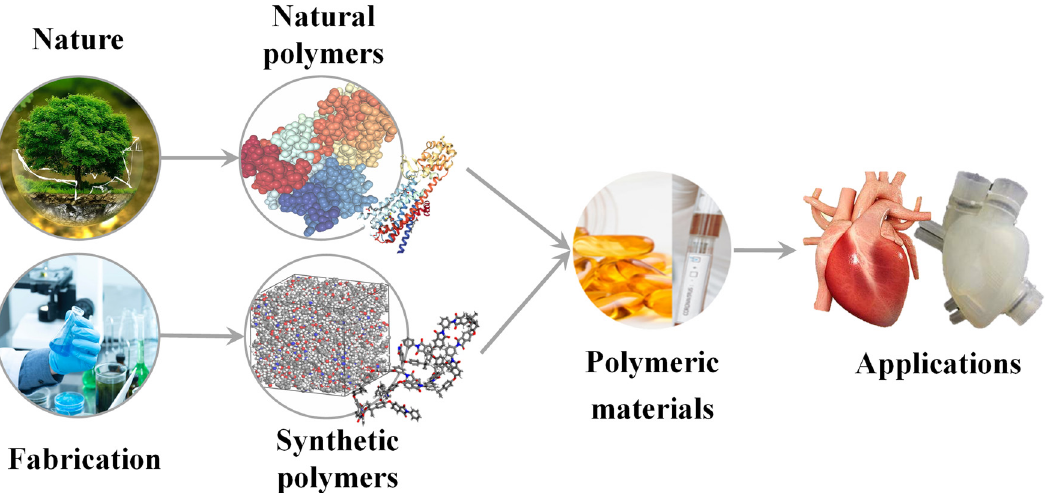
Figure 3: Nanostructures of polymeric materials in modeling. Polymers are separated into two types. One is natural polymer that can be found in a natural environment, and the other one is synthetic polymer from man - made